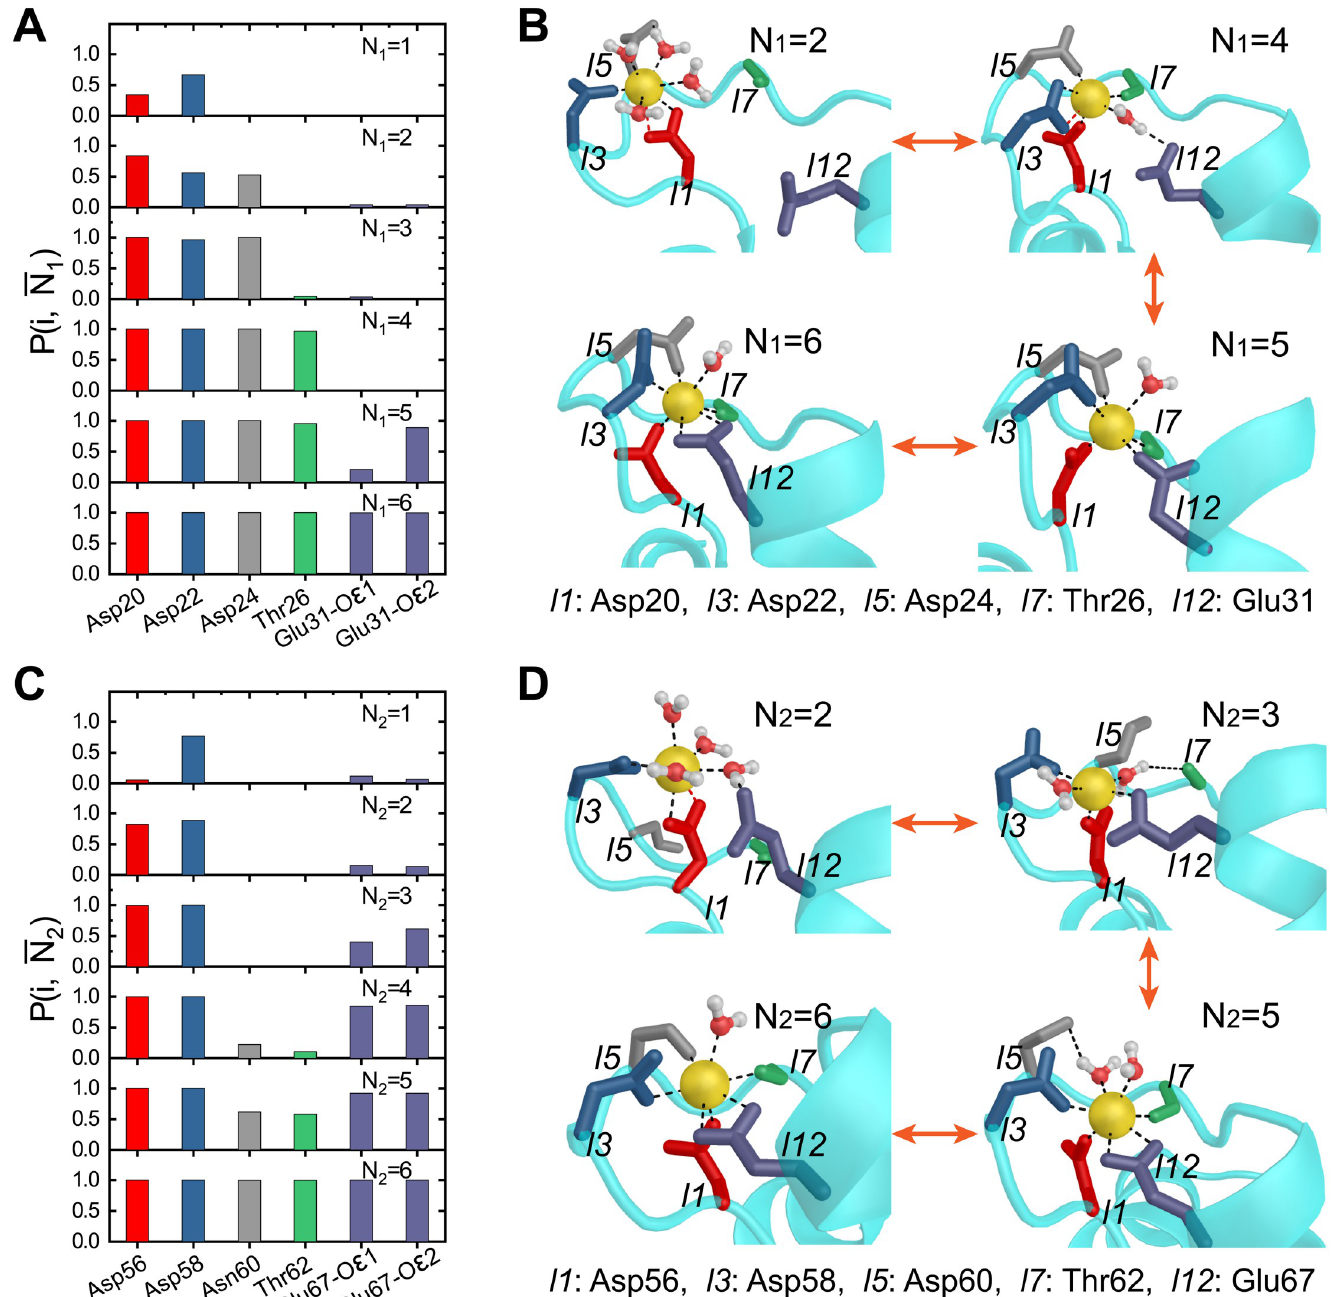
Fig 4. The Ca 2+ binding sequence of EF 1 and EF 2 . (A) Coordination probability P ð i ; N Ca 2+ are shown in different colors. (B) Schematic representations of the binding process of the native ligands. (C) and (D) show the binding sequence of the EF 2 .